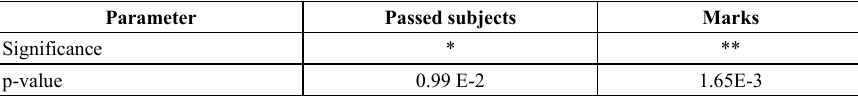
Table 7. Academic results comparison: gender gap in the lockdown Parameter